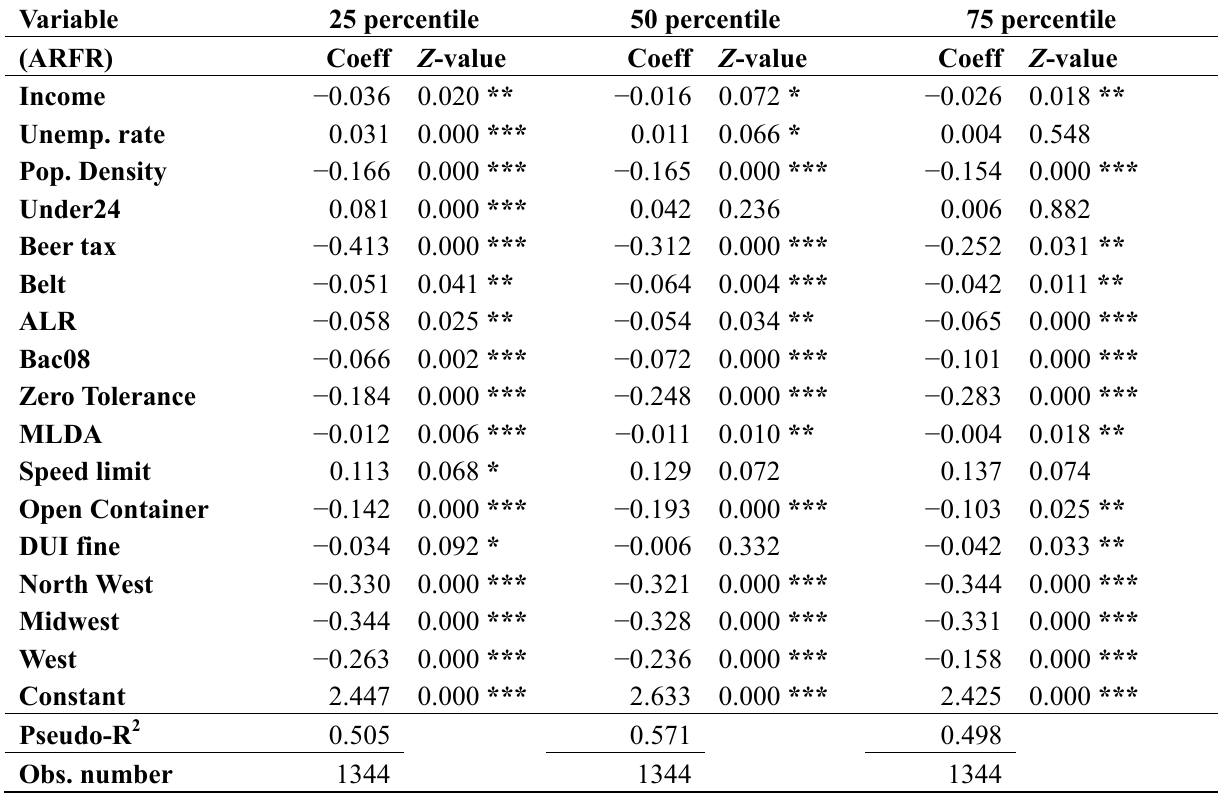
Table 2. Panel data quantile regression